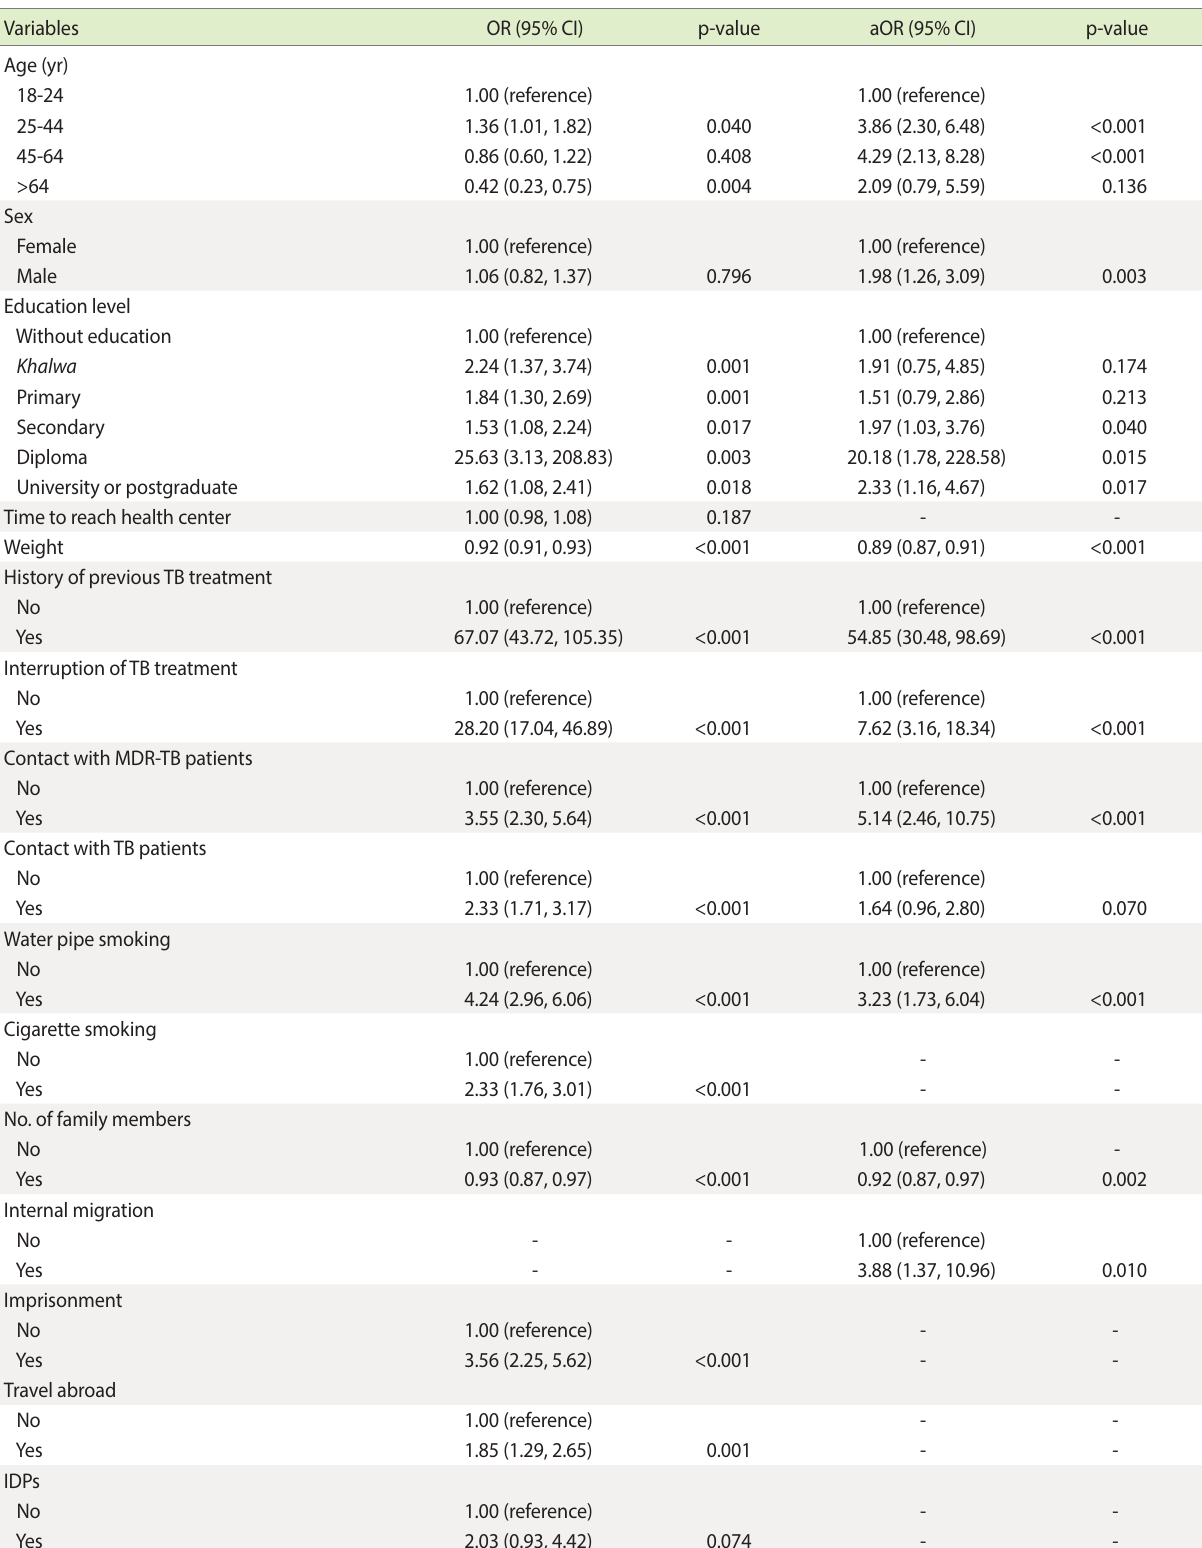
Table 2. Univariate and multiple logistic regression analysis of MDR-TB predictors